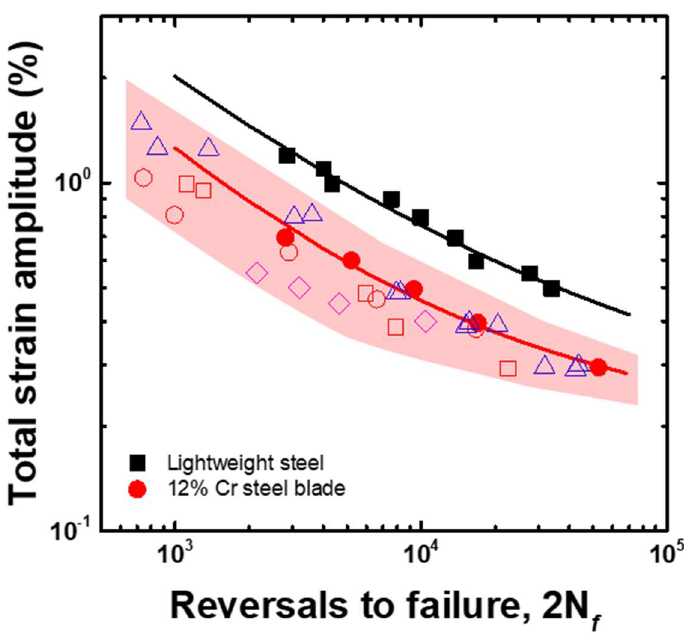
Figure 10. Comparison of the LCF life of 12% Cr and lightweight steels. Solid spots represent experimental results and open spots are from references. open squares and open circles [14], open triangles [15], and open diamonds [16].